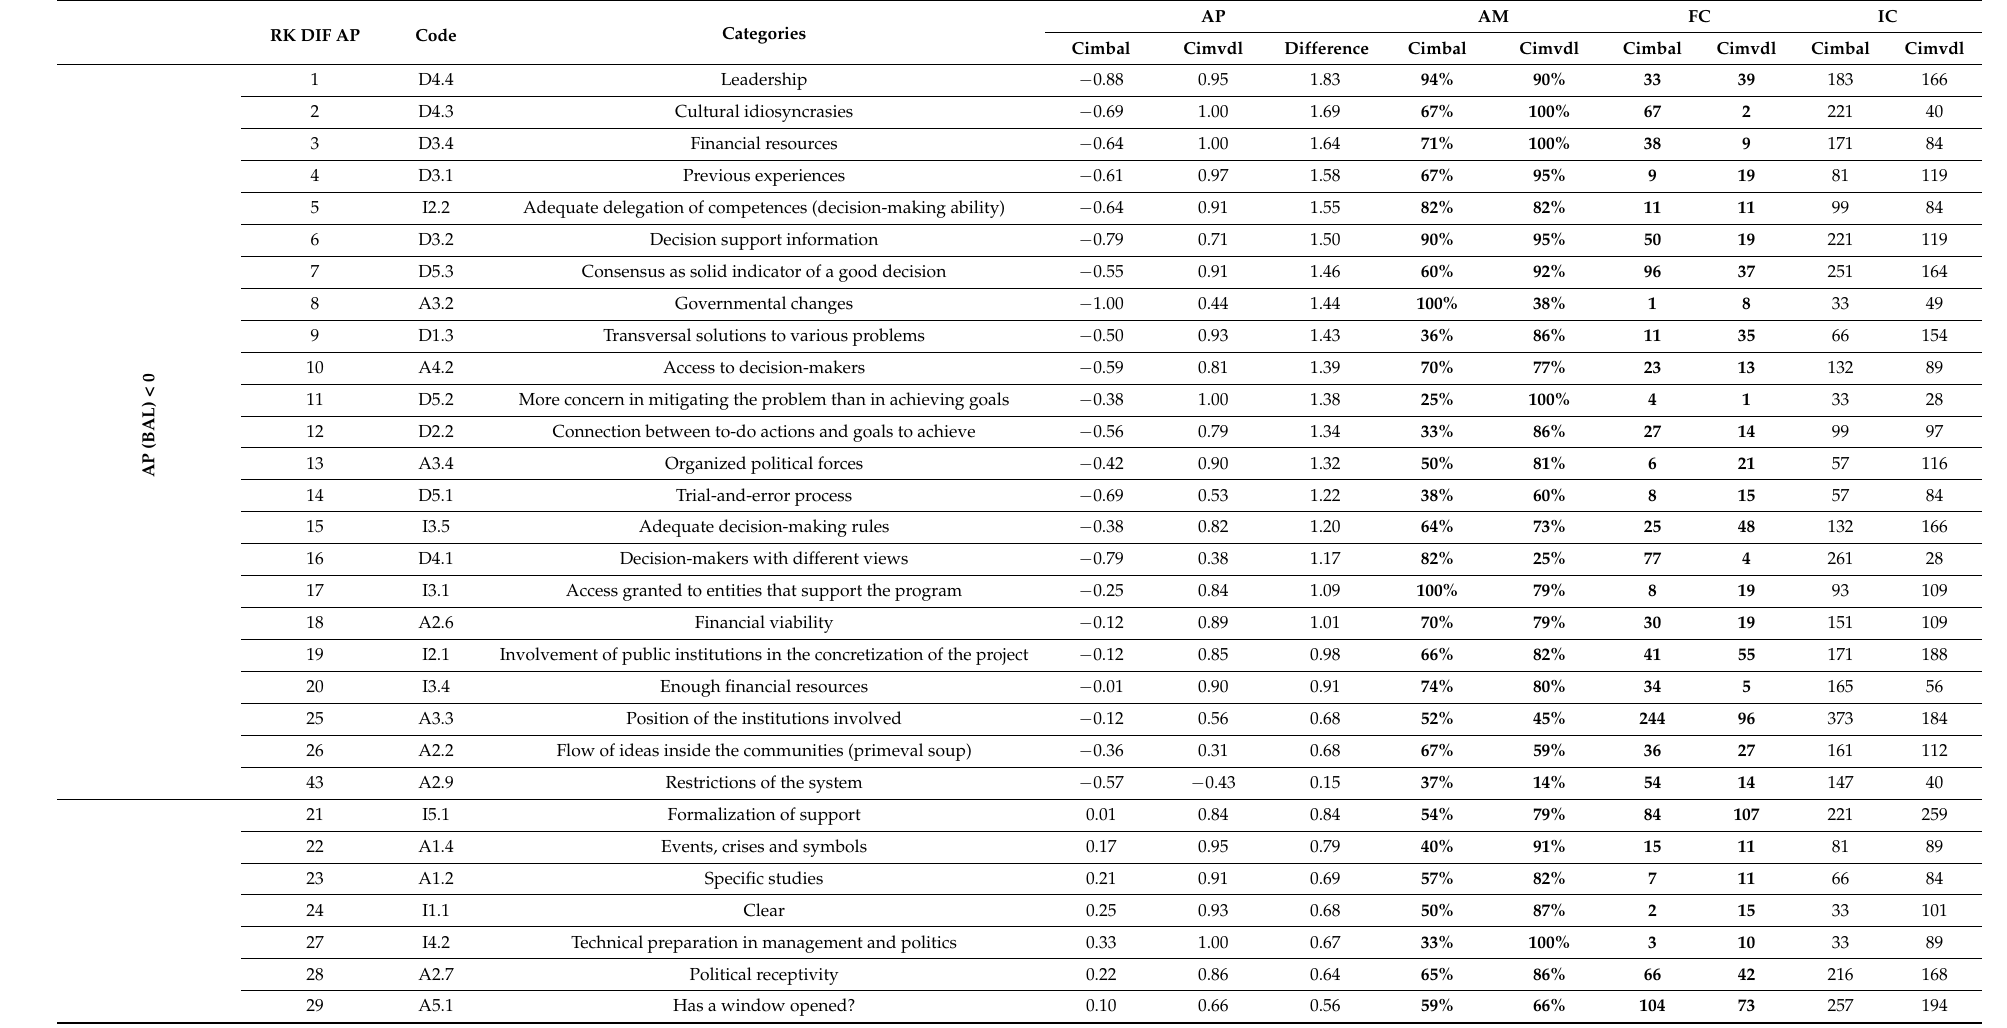
Table 7. Success and Failure According to the AP Indicator in the 53 Categories of the Proposed Model. Source: the